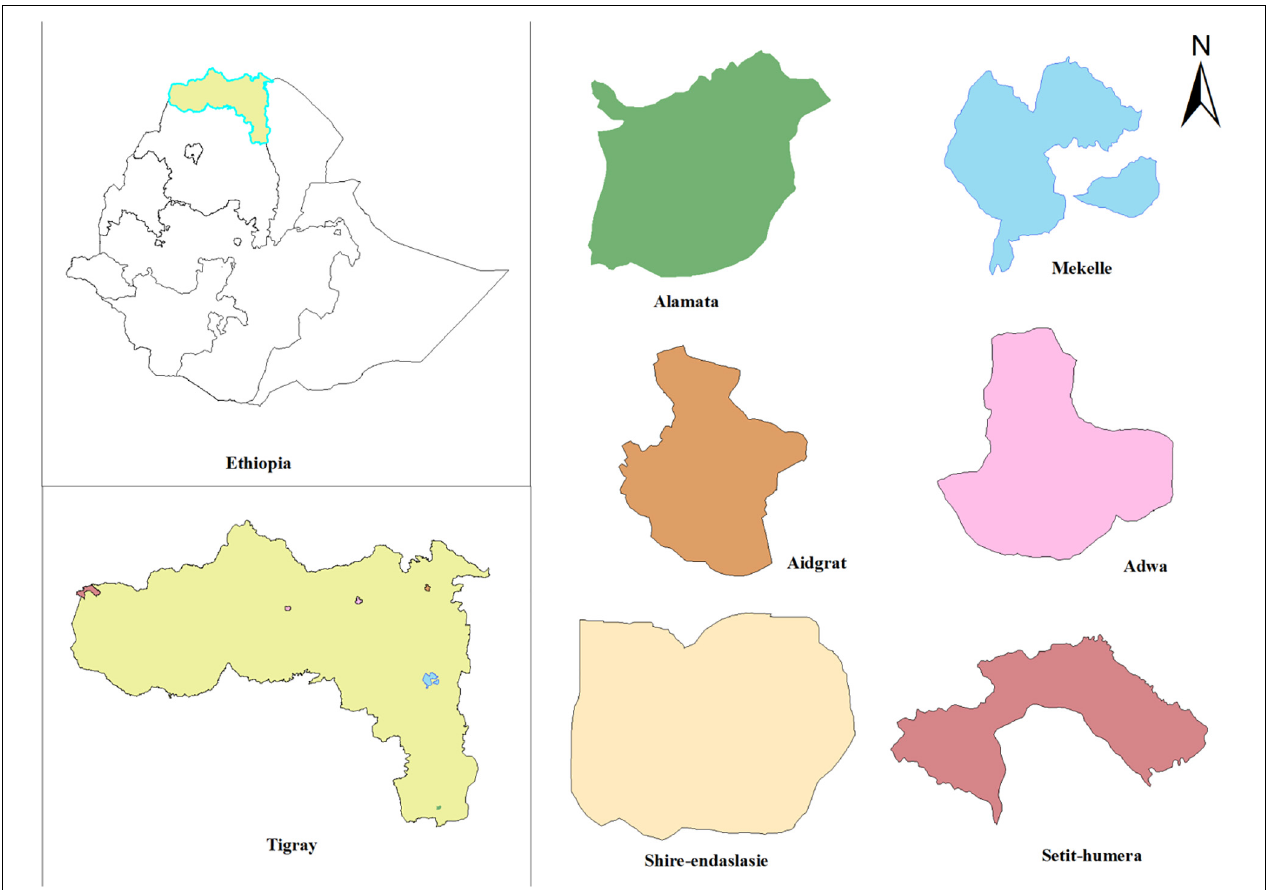
FIGURE 1 | Map of the study area showing locations of hospitals in Tigray Region, Ethiopia, July 2018–August